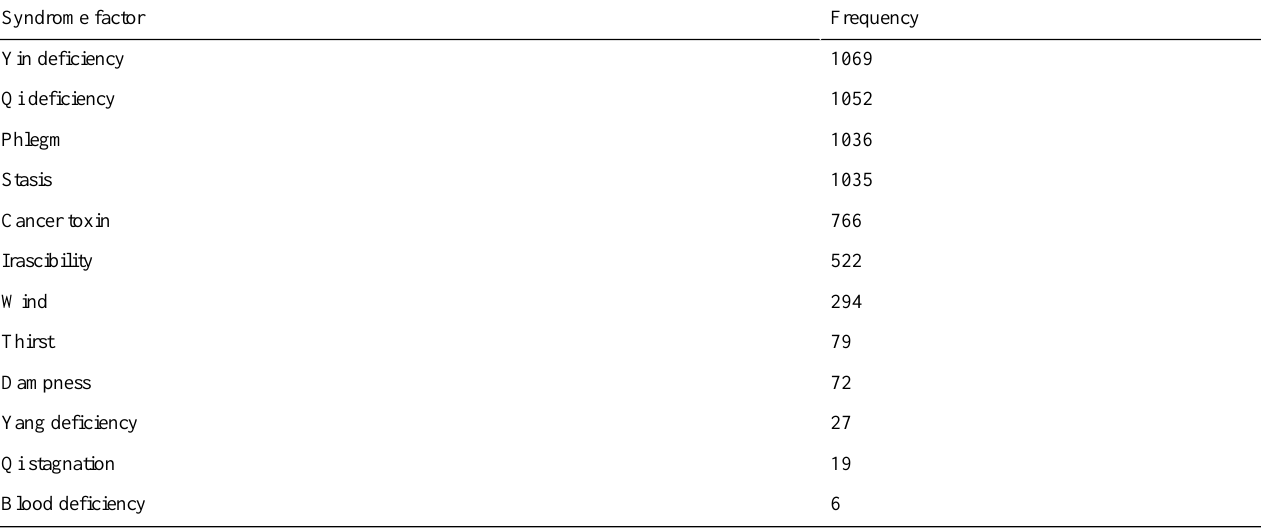
Table 1. TCM syndrome factors for lung cancer and their